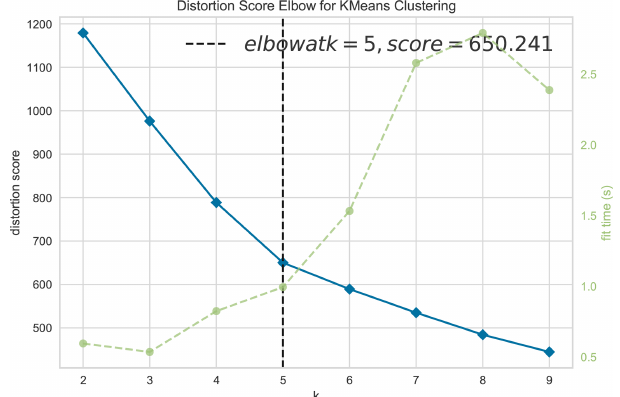
Figure C1. The distortion as a function of k (a.k.a. elbow plot) is shown as a blue line. The highest Calinski-Harabasz score is shown as a dashed black line. The consumed time as a function of k is shown as a dashed green